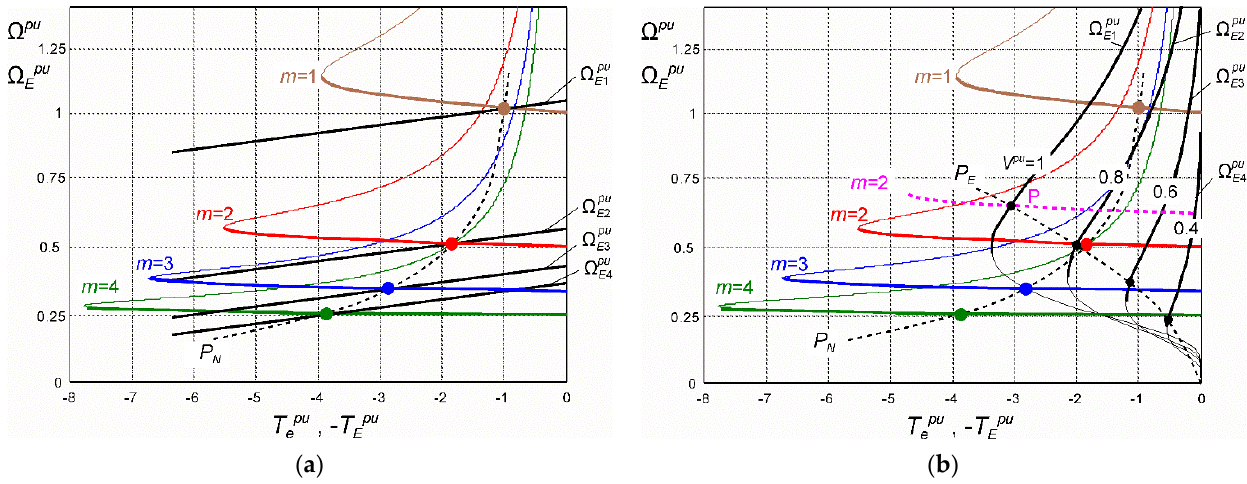
Figure 4. An example of the mechanical characteristics of a multiphase induction generator: ( a ) driven by a DC motor; ( b ) driven by a wind turbine (black thick lines: stable parts of wind turbine mechanical characteristics).